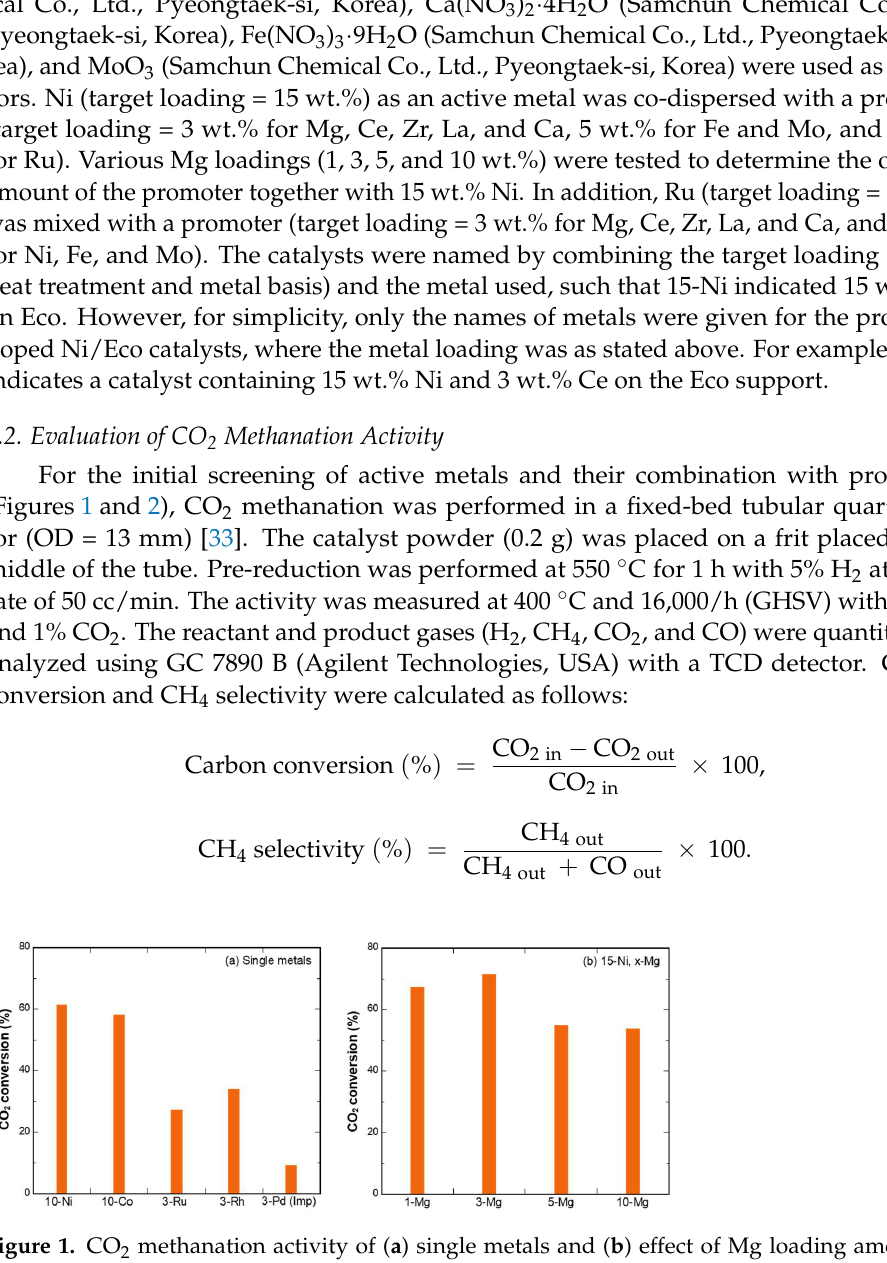
Figure 1. CO 2 methanation activity of ( a ) single metals and ( b ) effect of Mg loading amount on 15-Ni/Eco (400 °C, GHSV = 16,000 /h, with 4% H 2 and 1% CO 2 ).